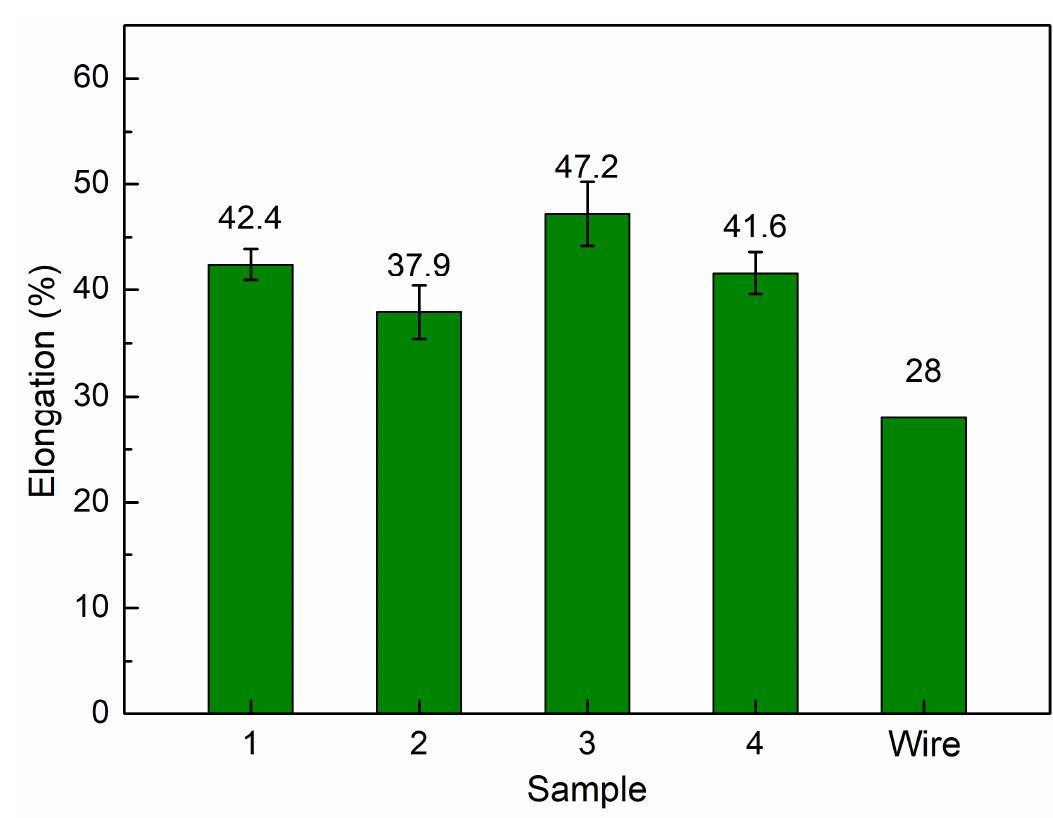
Figure 6. Average elongation of samples at di ff erent WAAM strategies.